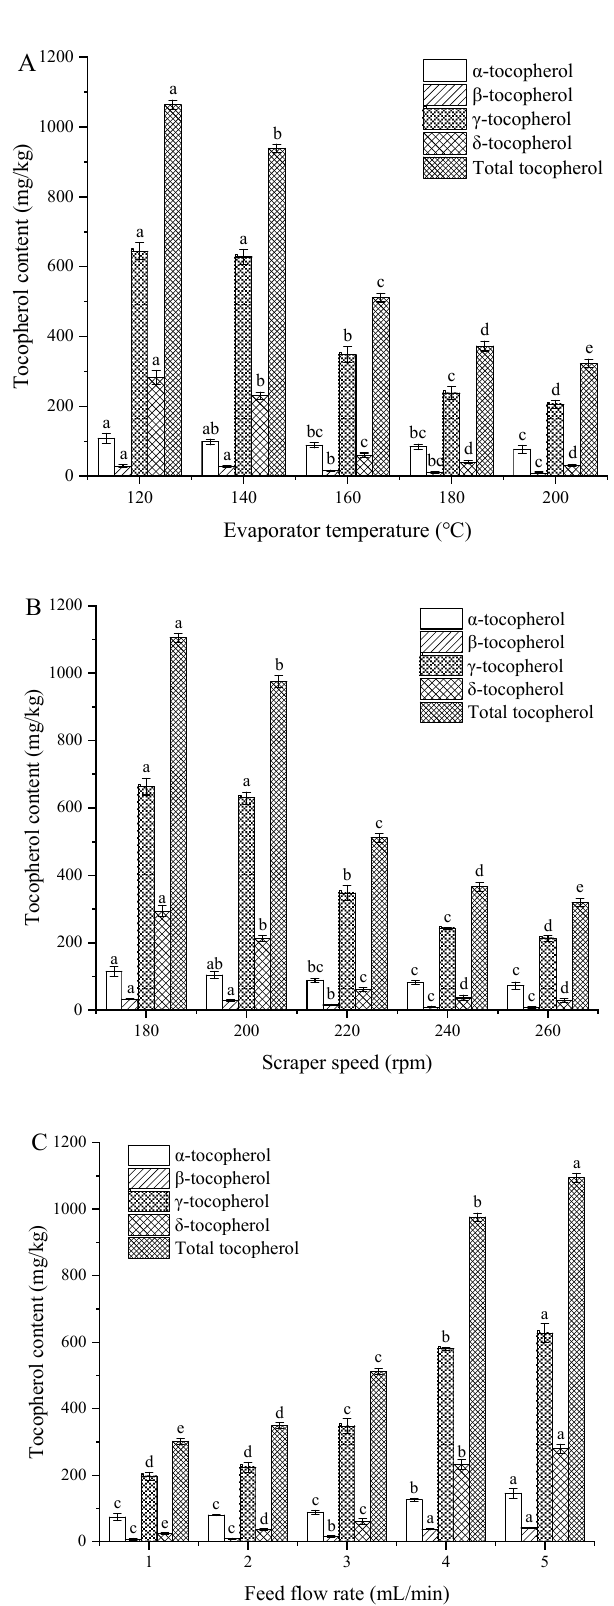
Figure 3. Effect of ( A ) evaporation temperature, ( B ) scraper speed, and ( C ) feed flow rate on the tocopherol contents of soybean oil. Note: Different letters indicate significant differences between the same groups ( p < 0.05).